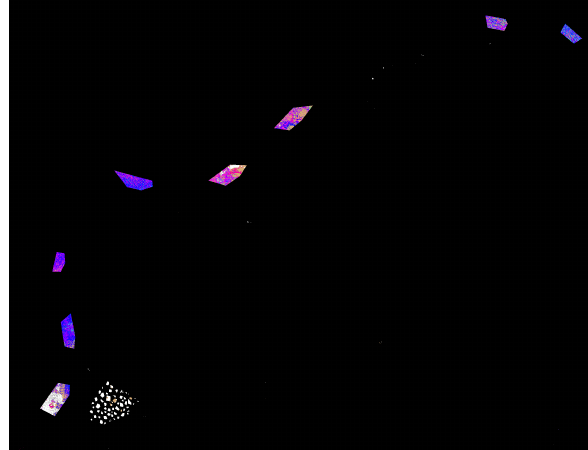
Figure 8. STL-map of the r 3 pattern for ground truth areas covered by maritime waters, between the towns of Saint-Paul and Saint-Denis.